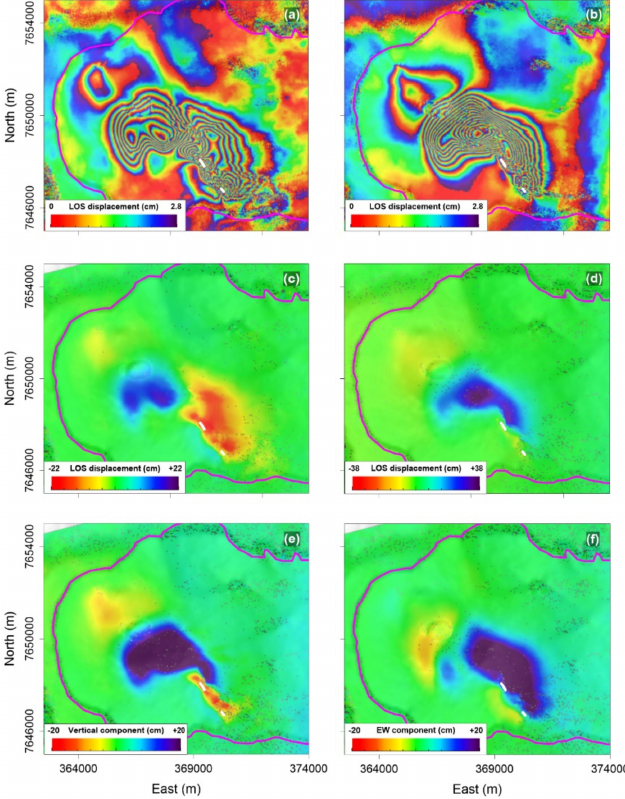
Figure 2. Deformation pattern from DInSAR: ( a , b ) wrapped interferograms generated from Sentinel-1 data pairs acquired along ( a ) ascending orbits on 2 and 14 August 2019, and ( b ) descending (DESC) orbits on 3 and 15 August 2019, respectively. ( c , d ) line-of-sight (LOS) displacement maps for S1 ascending ( c ) and descending ( d ) orbits interferograms. ( e ) Vertical and ( f ) East-West displacement maps obtained through the combination of the geocoded displacement maps computed from the ascending and descending orbits. The caldera rim (magenta line) and the eruptive fissures (white lines) are also shown. The reported data are superimposed on the 1 arcsec Shuttle Radar Topography Mission (SRTM) Digital Elevation Model (DEM) of the